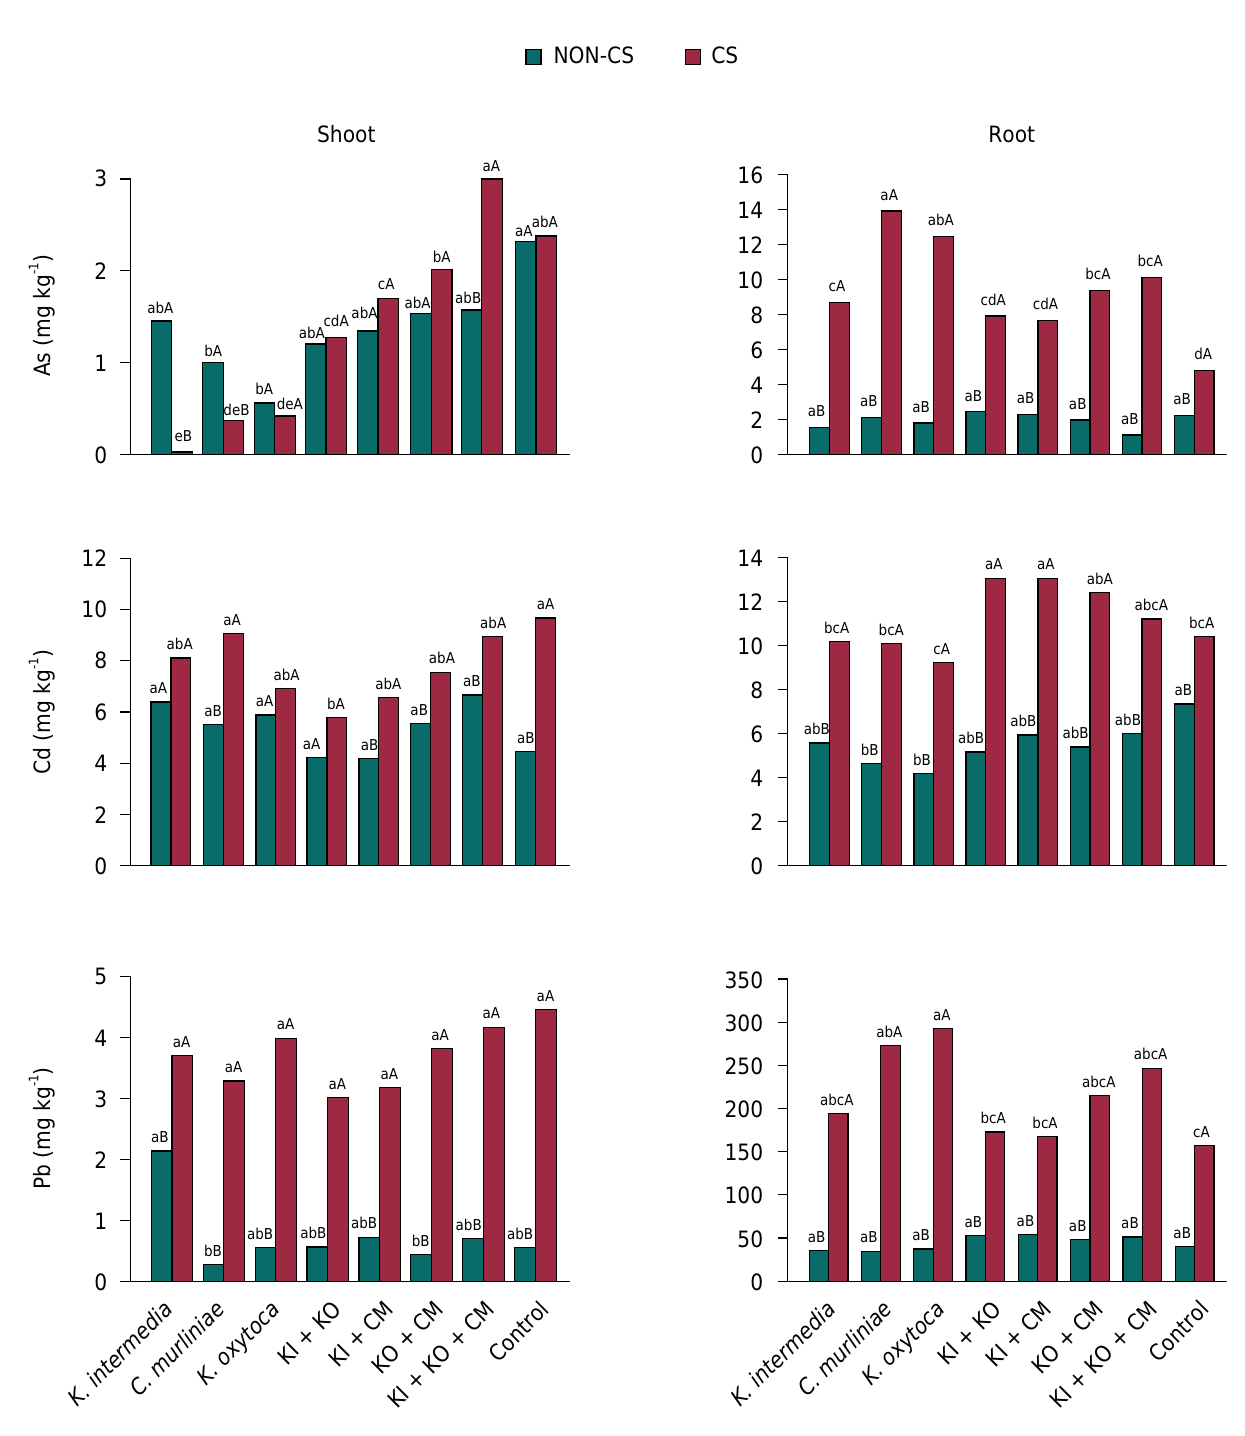
Figure 1. Heavy metals content in the shoot and root of Sorghum bicolor grown on heavy metals contaminated soil and inoculated with heavy metal resistant-rhizobacteria. KI: Kluyvera intermedia ; KO: Klebsiella oxytoca ; CM: Citrobacter murliniae . * Means followed by the same lowercase letter do not differ between treatments in each soil and same capital letter do not differ between soils in each treatment by Tukey test